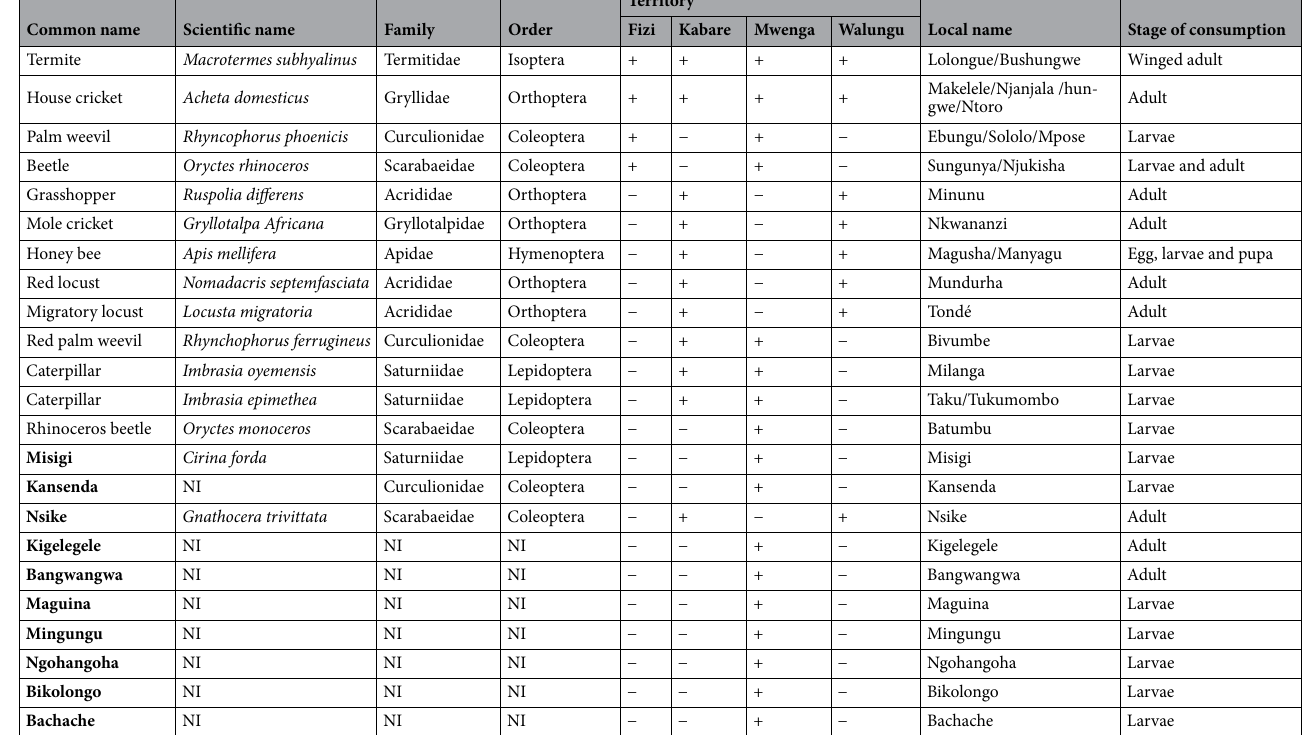
Table 2. Commonly consumed edible insects in selected Territories of South-Kivu. + Insects present and consumed, − Insects not present, NI not identified. All of these edible insects are identified by local names, mainly in the dialects Kibembe (Fizi), Kirega (Mwenga) and Mashi (Kabare and Walungu) that are attached to specific physical characteristics or